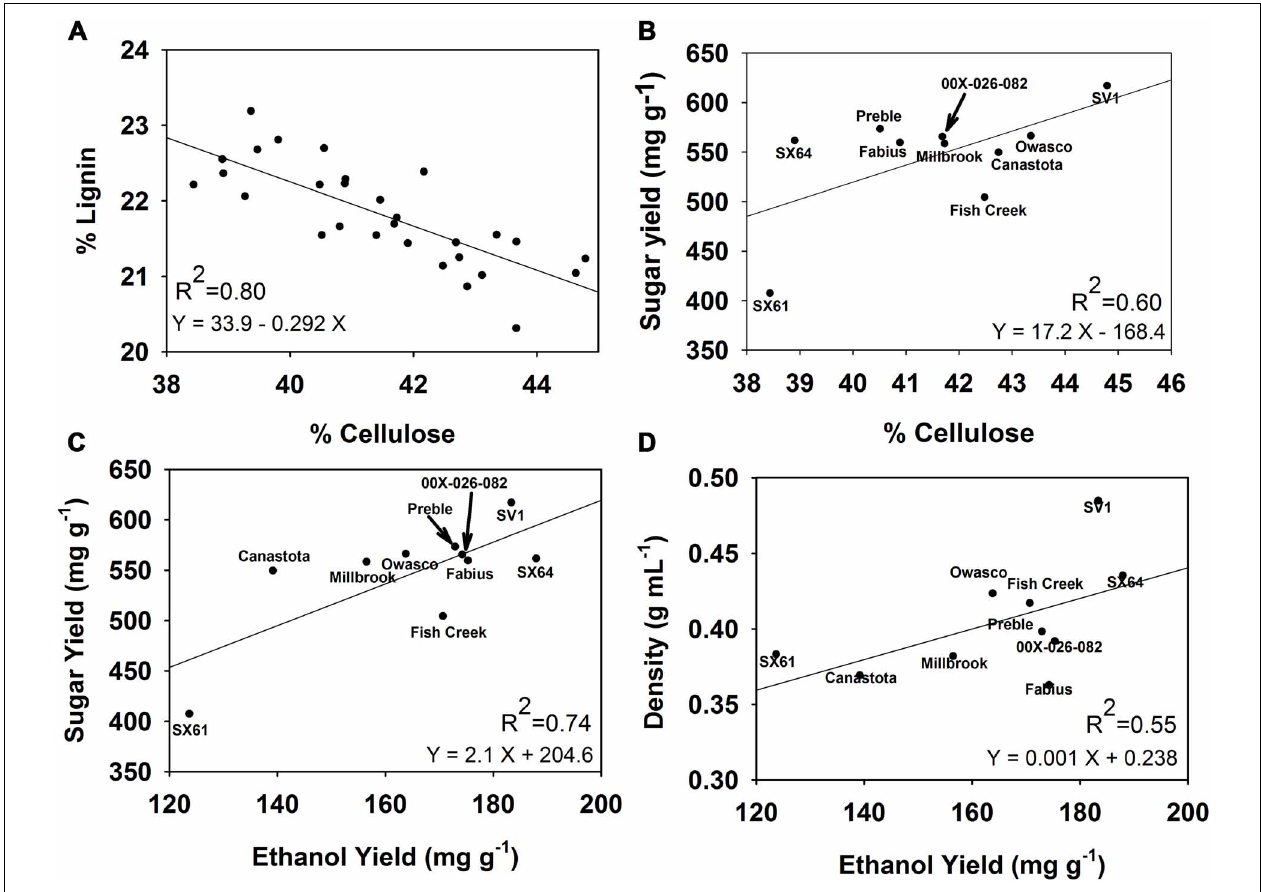
FIGURE 6 | Correlations observed among woody biomass traits, sugar release, and ethanol yield. (A) % Lignin vs. % cellulose, (B) total sugar yield vs. % cellulose, (C) total sugar yield vs. ethanol yield, and (D) wood density vs. ethanol yield.